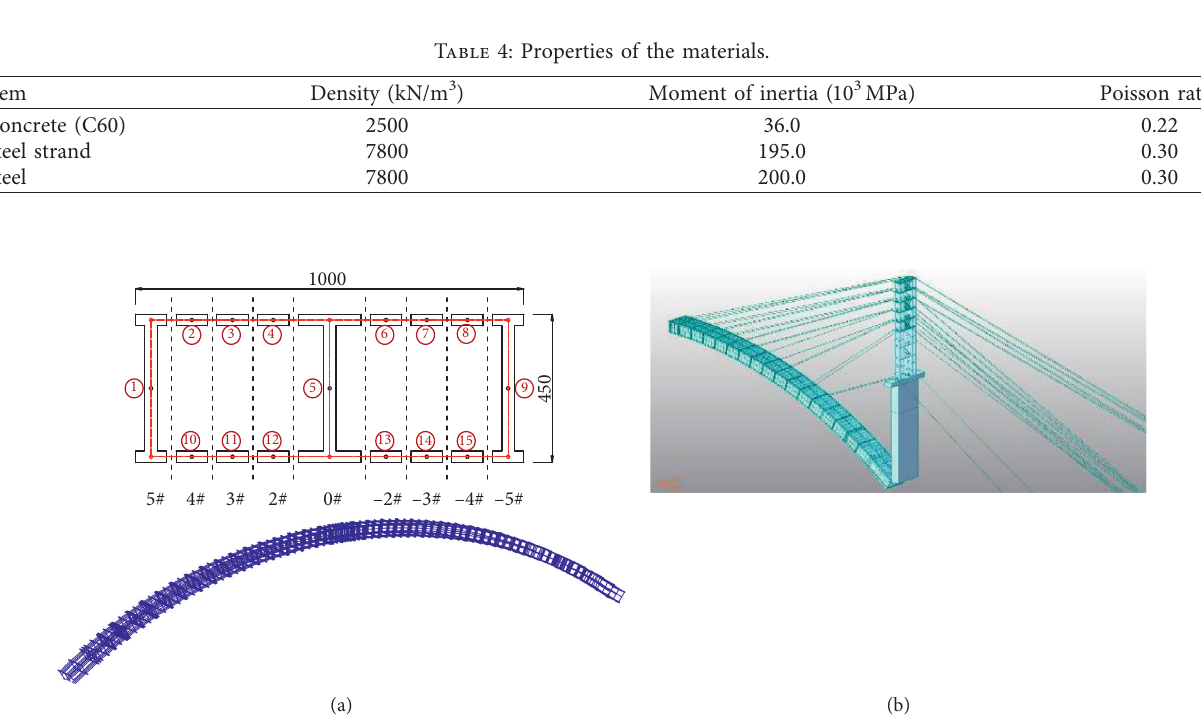
Figure 10: Spatial grillage modeling of the Shatuo Bridge under construction (unit: cm). (a) Cross-sectional division and arch ring model. (b) Spatial grid model of construction